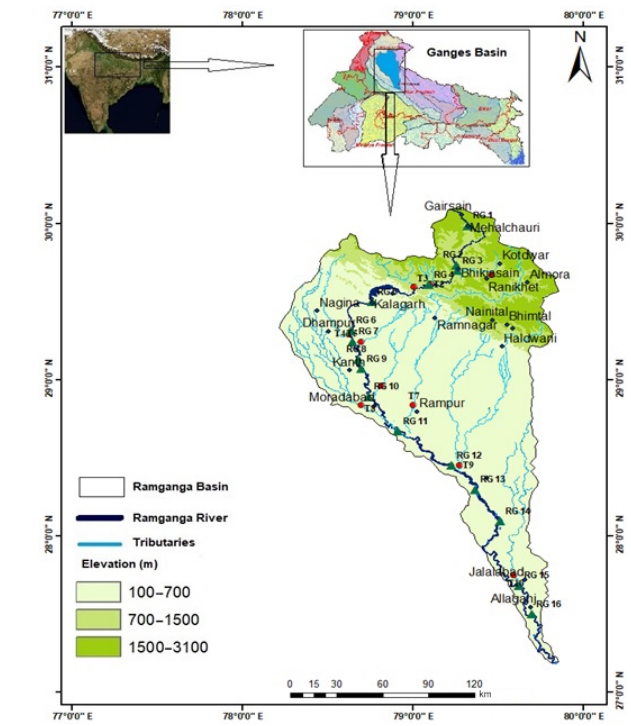
Figure 1. The Ramganga River basin with the sampling locations for the present study.